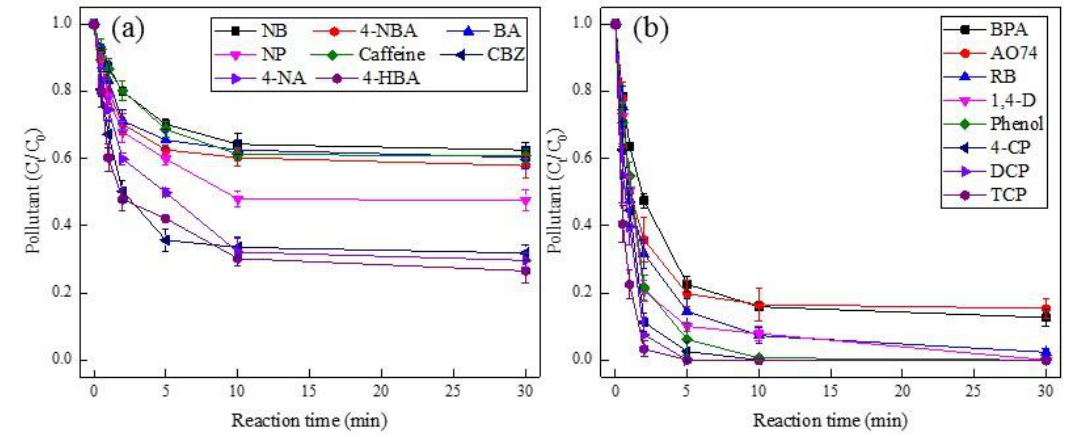
Figure 4. Degradation of various pollutants in Pd(II)/PMS system. Condition: [pollutant] = 50 µM, [PMS] = 0.25 mM, [Pd(II)] = 25 µM, pH i = 4. ( a ) for the target compounds of NB, 4-NBA, BA, NP, Caffeine, CBZ, 4-NA, and 4-HBA; ( b ) for BPA, AO74, RB, 1,4-D, Phenol, 4-CP, DCP, and TCP.